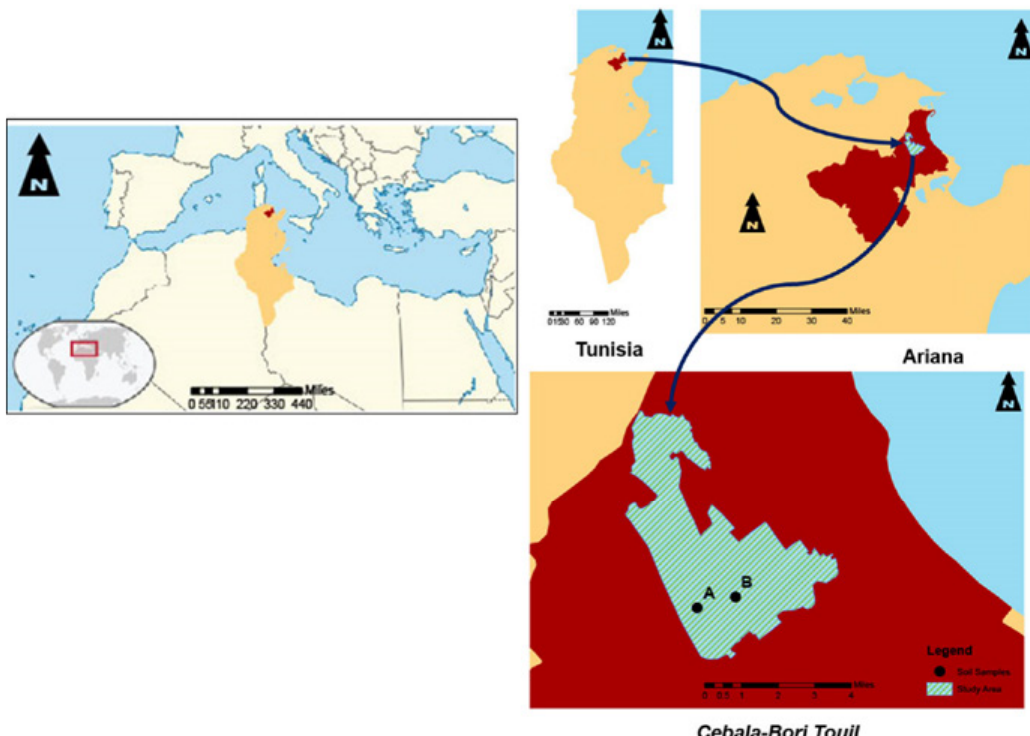
Fig. 1 : Geographic location of the study area in northern Tunisia and localization of soil samples in Cebala Borj Touil